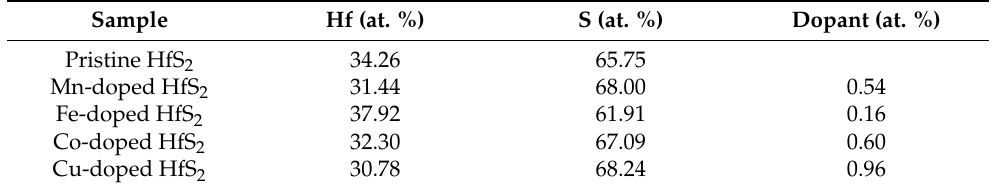
Table 1. Atomic percentages of Hf, S, and dopants in the pristine, Mn-, Fe-, Co-, and Cu-doped HfS 2